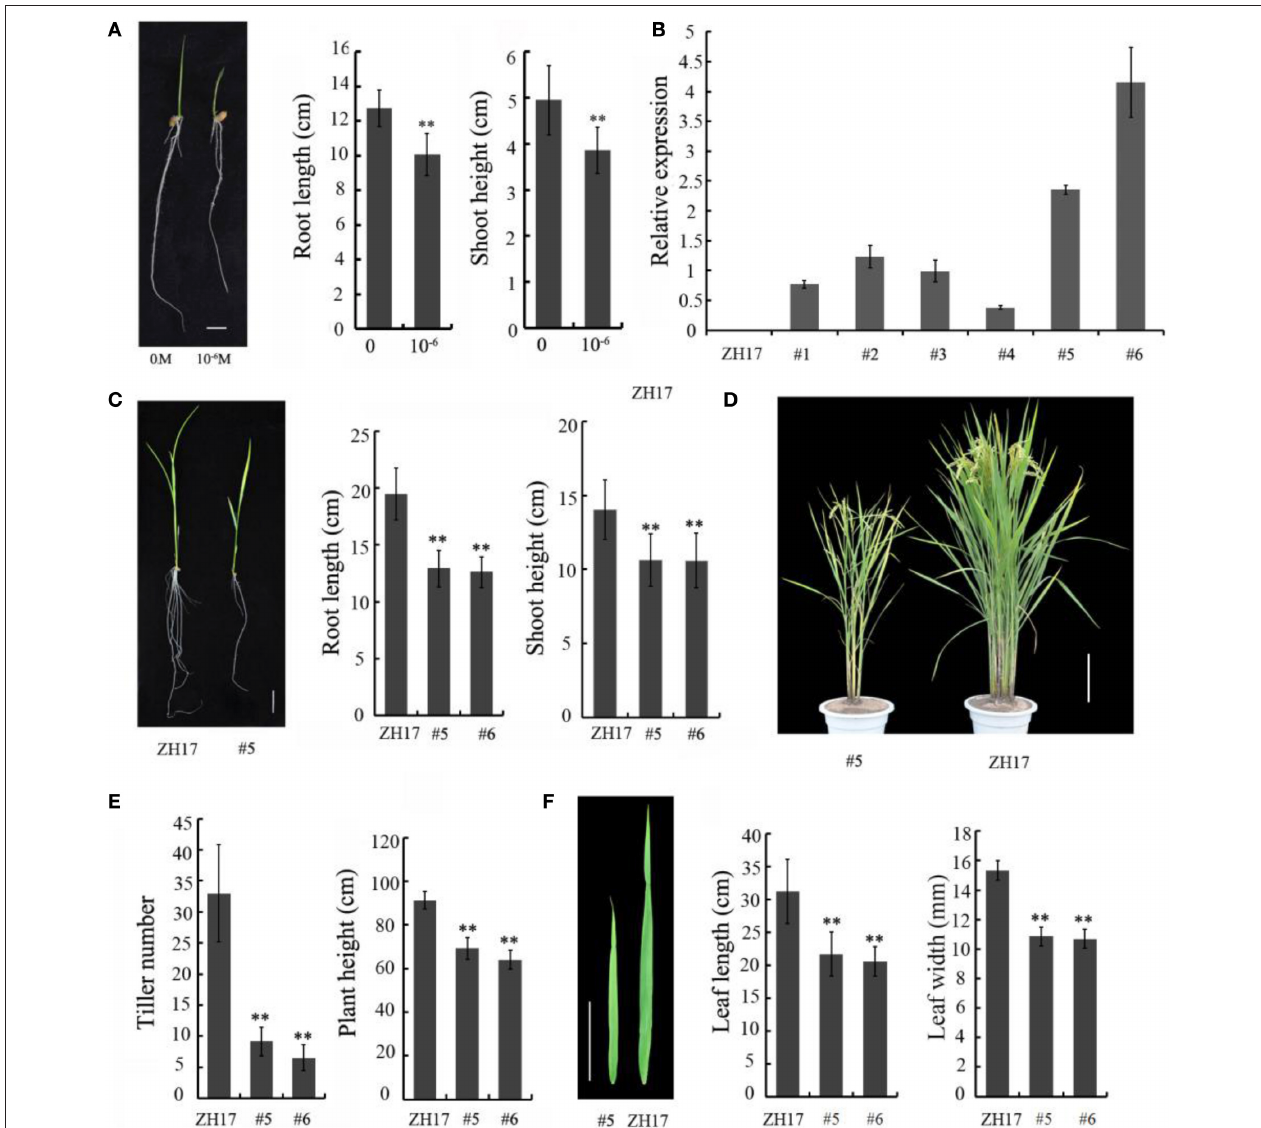
FIGURE 4 | Overexpression of OsCEP6.1 negatively affected the vegetative growth of rice. (A) Comparison of the root length and shoot height between the control and seedlings with synthetic CEP at the 8-day-old stage. The growth of shoot and root was significantly repressed by synthetic CEP peptide, by 17 and 20%, respectively. Bar = 1cm. The values are means ± SD ( n = 18 ), ** P < 0.01 . (B) Quantitative RT-PCR analysis revealed the high expression level of OsCEP6.1 in six overexpression lines at the T0 generation, particularly lines #5 and #6. (C) Comparison of the root length and shoot height of the transgenic lines (#5) and control at the 14-day-old seedlings. The growth of shoot and root was significantly repressed by approximately 25% in the transgenic line compared with the control. Bar = 2cm. The values are means ± SD ( n ≥ 10 ), ** P < 0.01 . (D) Overexpression of OsCEP6.1 leads to phenotypic variation at the mature stage including plant stature and panicle architecture. Bar = 20cm. (E) OsCEP6.1 overexpression lines exhibited significantly fewer tillers and shorter height compared with those of the control. (F) Both the length and width of flag leaves were significantly smaller in the transgenic line (#5 and #6) than those in the control. Bar = 10cm. The values are means ± SD ( n ≥ 12 ), ** P < 0.01